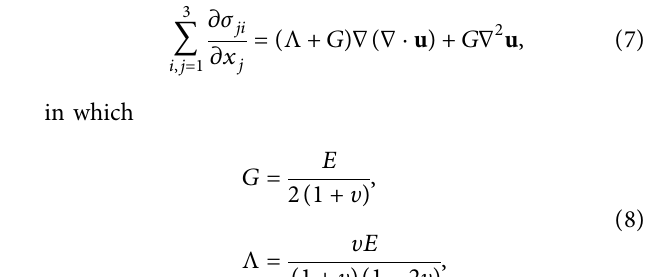
Figure 2: The discretized quasi-rectangular element and nodes in a local coordinate system ( p , q , n ). J current density; ( i , j ) indicates the index of corresponding